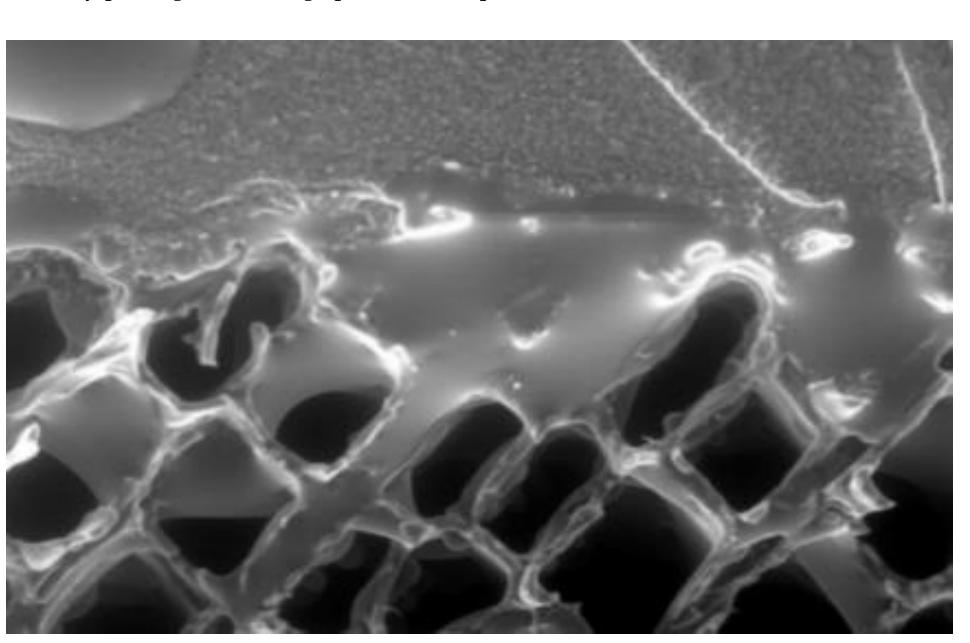
Figure 14. Paper impregnated with melamine on the surface of pine ( A ) and a walnut veneer on the surface of pine ( B ).